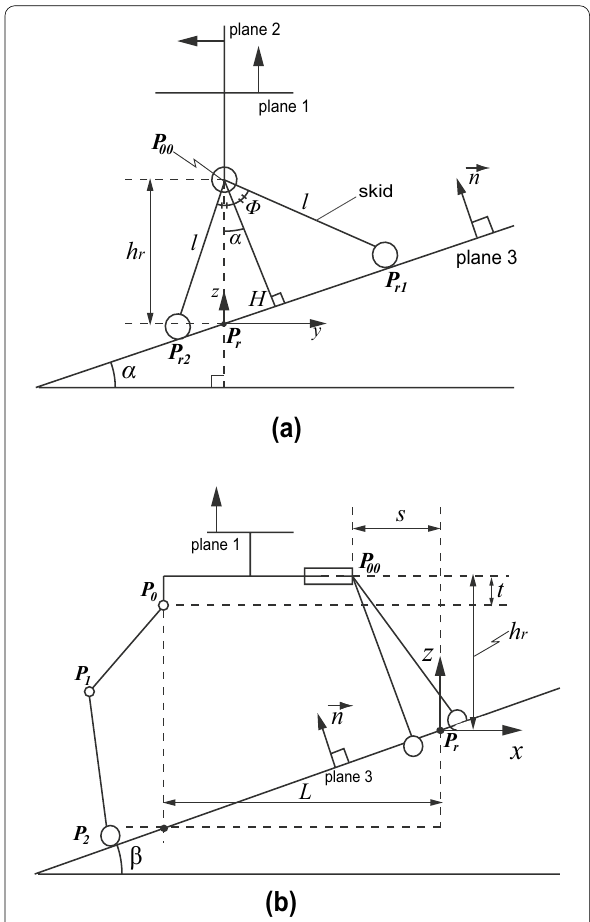
Fig. 6 View of the device from A and B